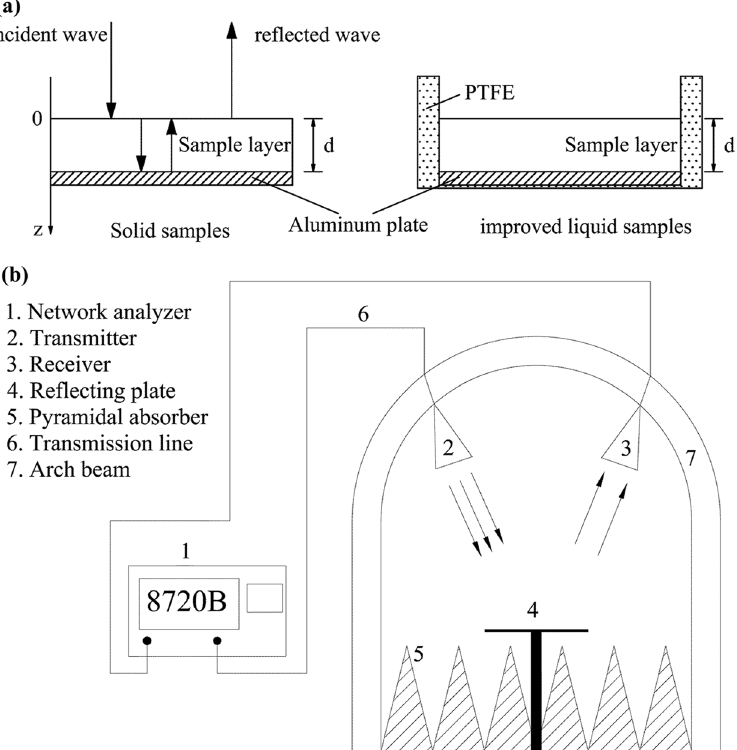
Figure 1. The arch method testing system for liquid samples. ( a ) The improved specialized container for liquid samples ( b ) The schematic diagram of the arch method testing system.